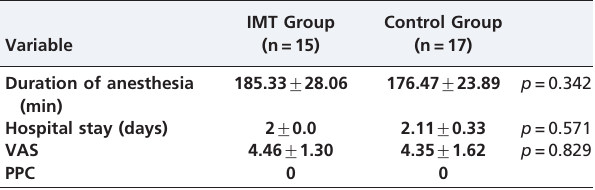
Table 2 - Surgery Data (values expressed as mean and